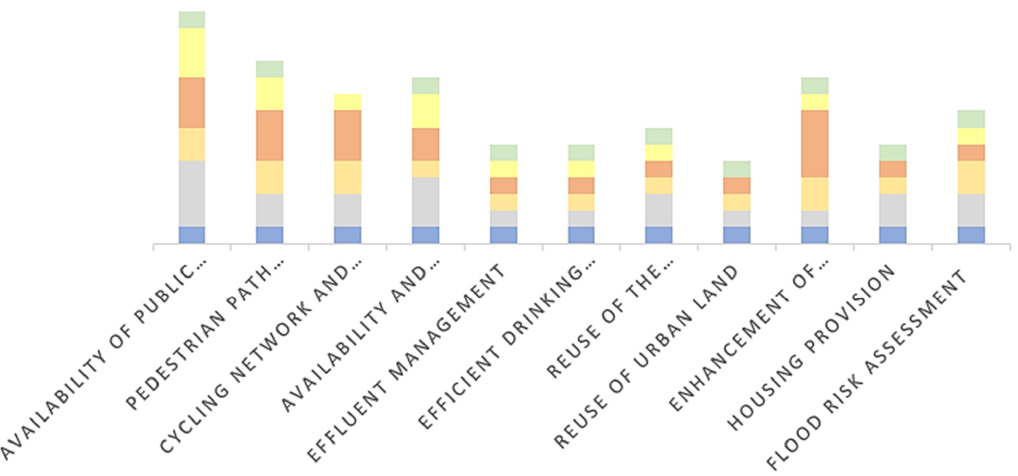
Figure 14. Frequency distribution of each indicator included in the four sustainability tools: SBTool PT _Urban (2018), SNTool Min (2020), BREEAM-C (2012), LEED-ND (2018), and supported by ISO 37120, and/or SDGs.